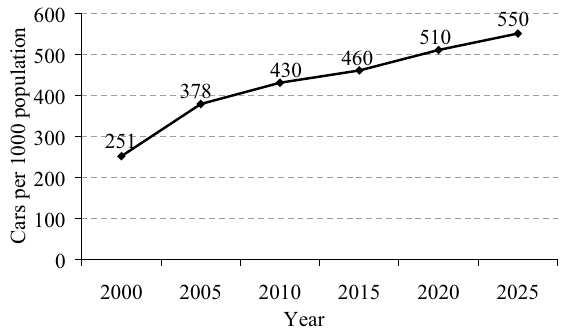
Fig. 2. The level of car ownership in Molėtai City and its forecast (cars/1000 population) according Comprehensive Plan of Molėtai City